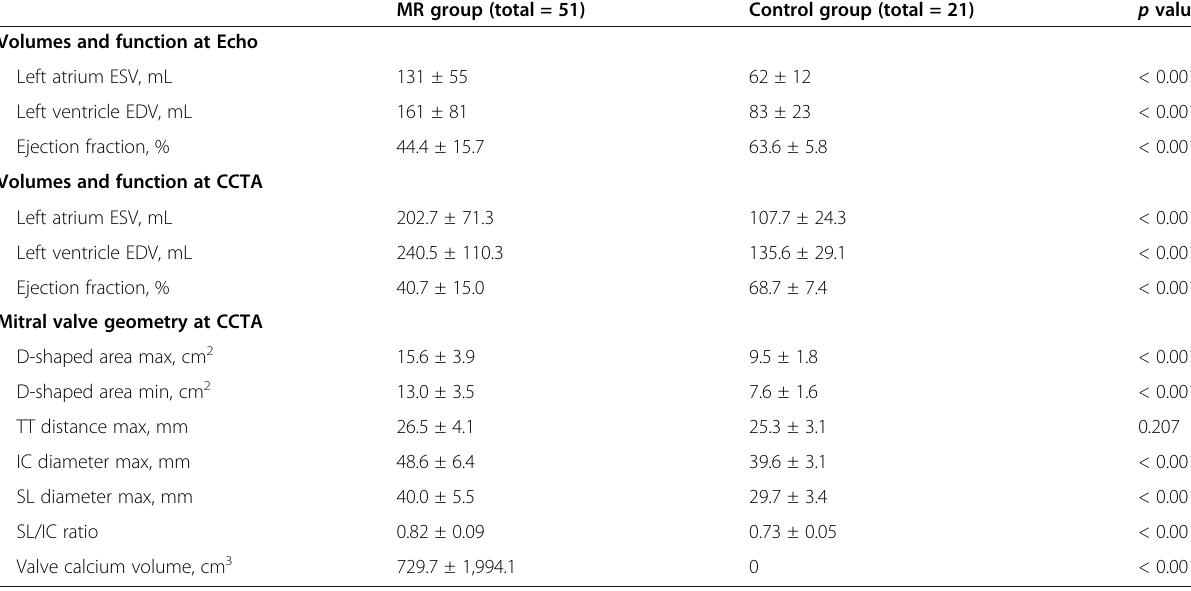
Table 2 Left cardiac chamber volumes and mitral annulus metrics in MR and control subjects